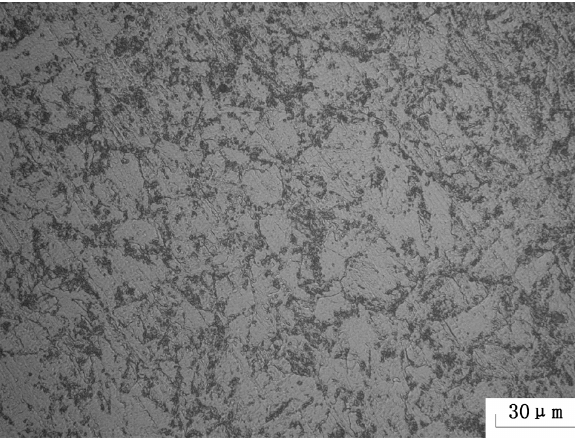
Figure 2: The initial microstructures of the